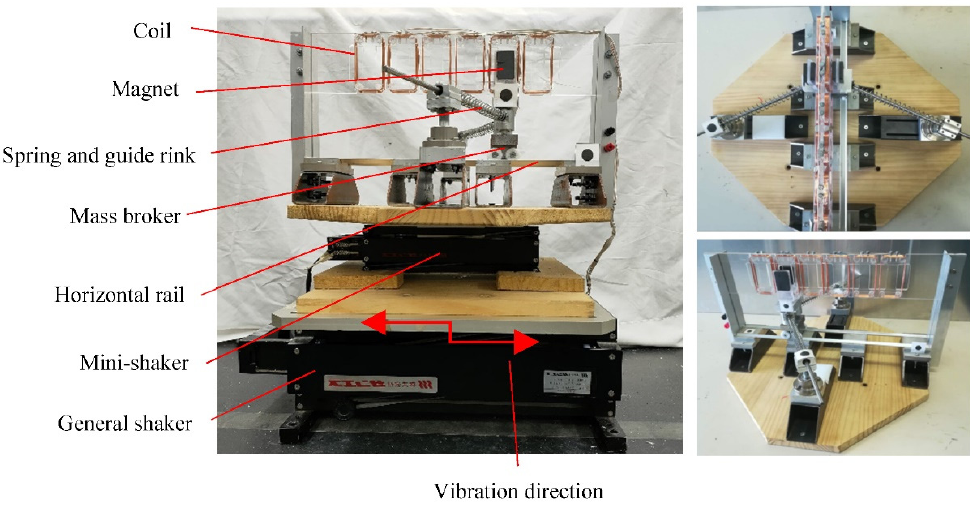
Figure 1. Horizontal large-scale bi-stable vibration-harvesting experimental equipment.